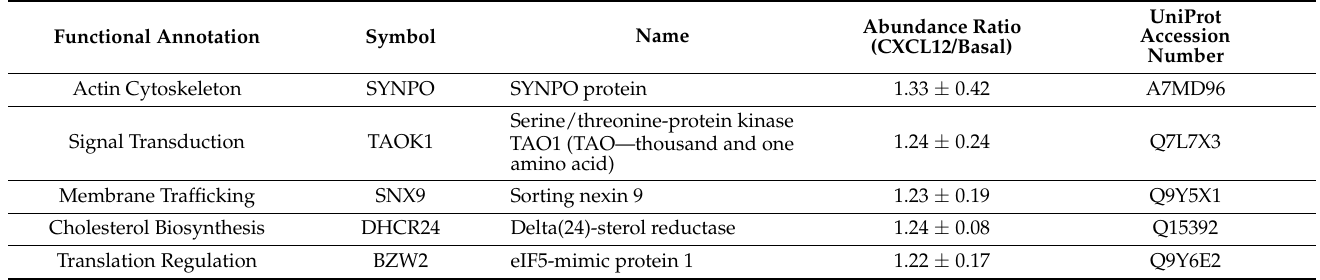
Table 1. High confidence proximity labeled proteins. High-confidence proteins (90% confidence interval) are classified based on their functional annotation. The abundance ratios are the average from three independent experiments ± the standard